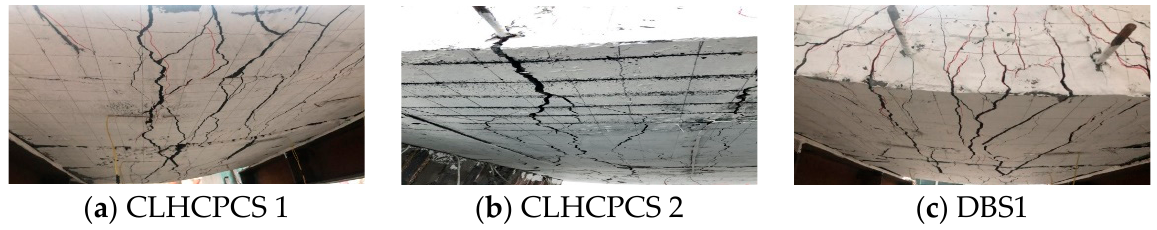
Figure 19. The Crack pattern at the bottom of the three composite slabs.